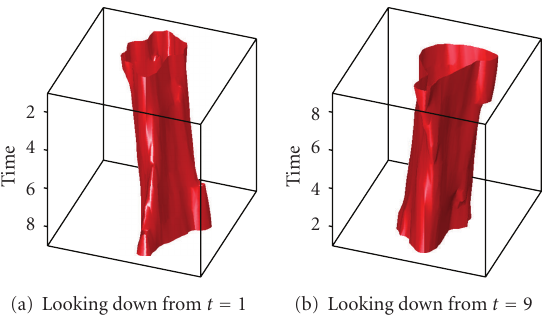
Figure 14: 3D representation of the cell